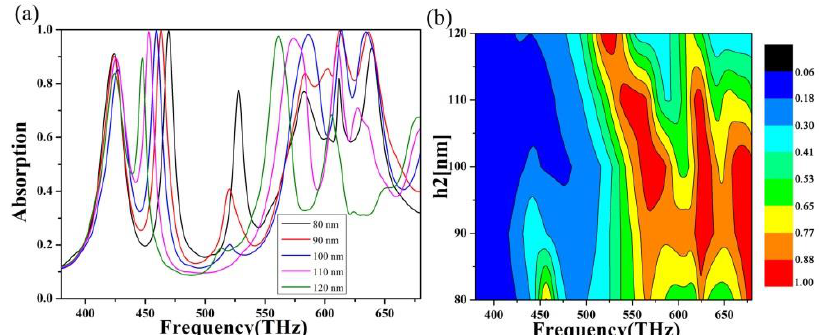
Figure 4. ( a ) Absorption curve and ( b ) absorption images of scanning dielectric layer thickness (80–120 nm) at 380–680